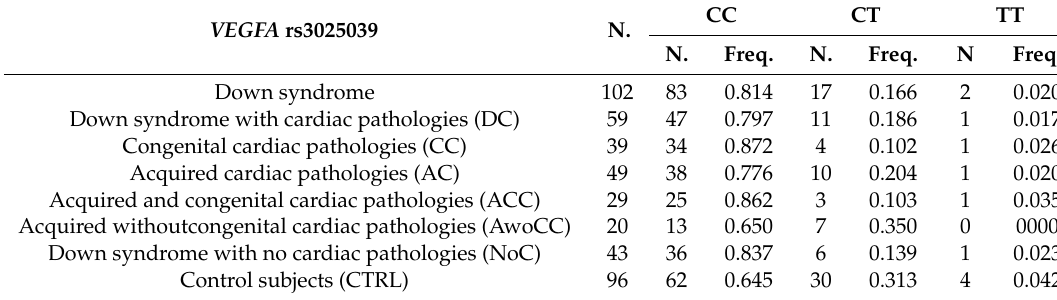
Table 9. VEGFA rs3025039 genotype frequencies of patients with DS and controls. VEGFA rs3025039 N.